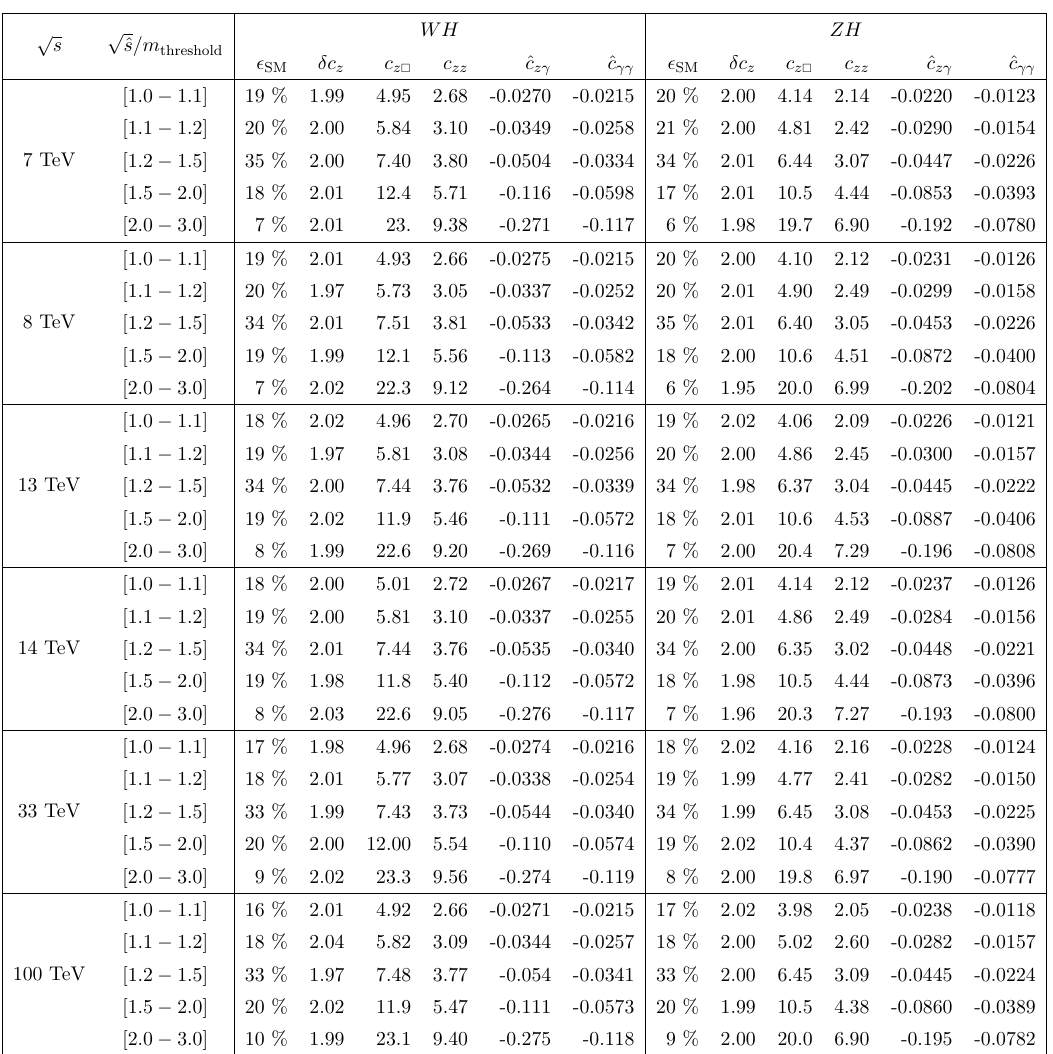
Table 5 . E(cid:11)ective (cid:12)eld theory coe(cid:14)cient for each bin in the ^ s di(cid:11)erential distribution. The bins extrema are expressed in units of m threshold (cid:17) m V + m h . The (cid:15) sm columns list the percentage of events that belong to each bin in the SM distribution.